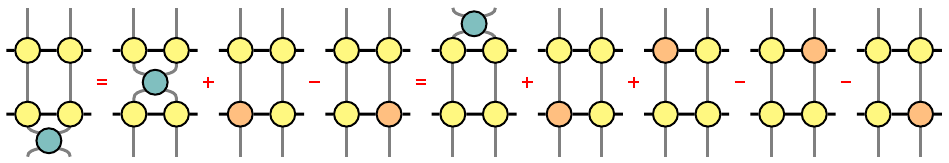
Figure 4: A schematic depiction of h n | m ( (cid:76) Λ ( z ) (cid:254) (cid:76) Λ ( z )) , representing the local action of the Hamiltonian H n | m on the density operator ρ ∞ = Ω and spectral and representation parameters are suppressed for clarity). The process of brining the interaction h n | m across the horizontal legs generates terms which can be interpreted as a operator divergence condition for two-row Lax operators (cid:76) Λ ( z )